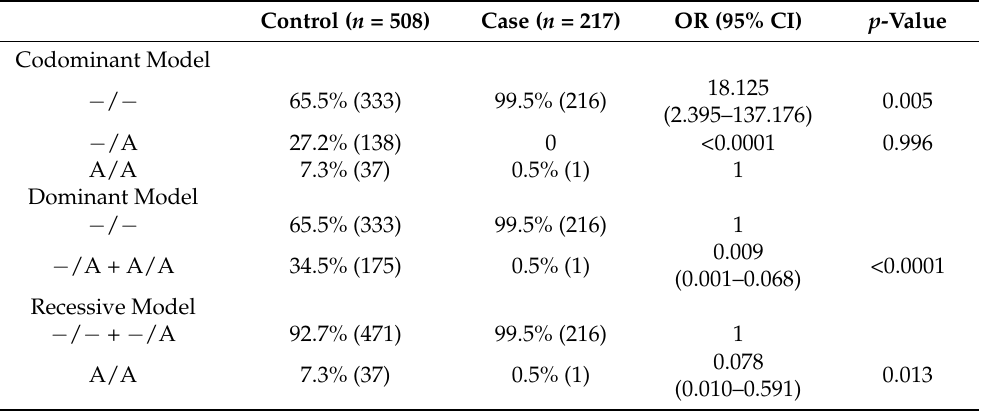
Table 7. Logistic regression analysis of the association of LPL rs293 with coronary heart disease (CHD) adjusting for age and sex in 725 Kuwaitis.